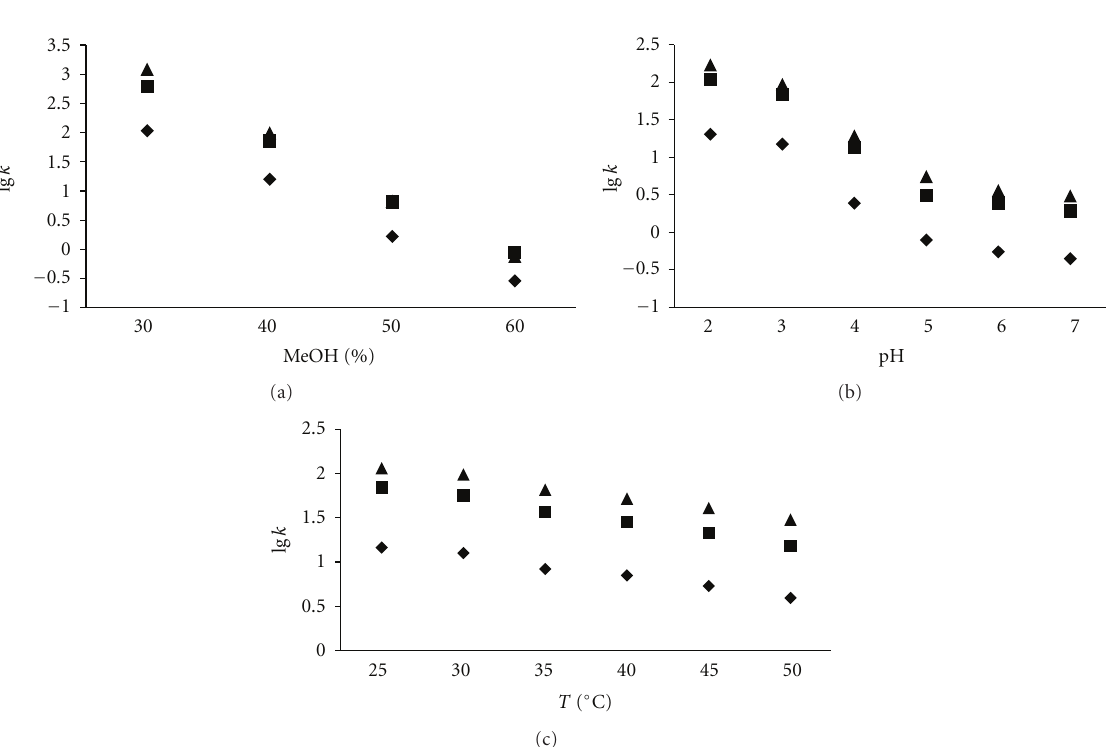
Figure 2: The influence of methanol % v/v concentration (a), mobile phase pH (b), and temperature (c) on the retention factors of IAA ( (cid:2) ), IPA ( (cid:3) ), and ABA ( (cid:4)